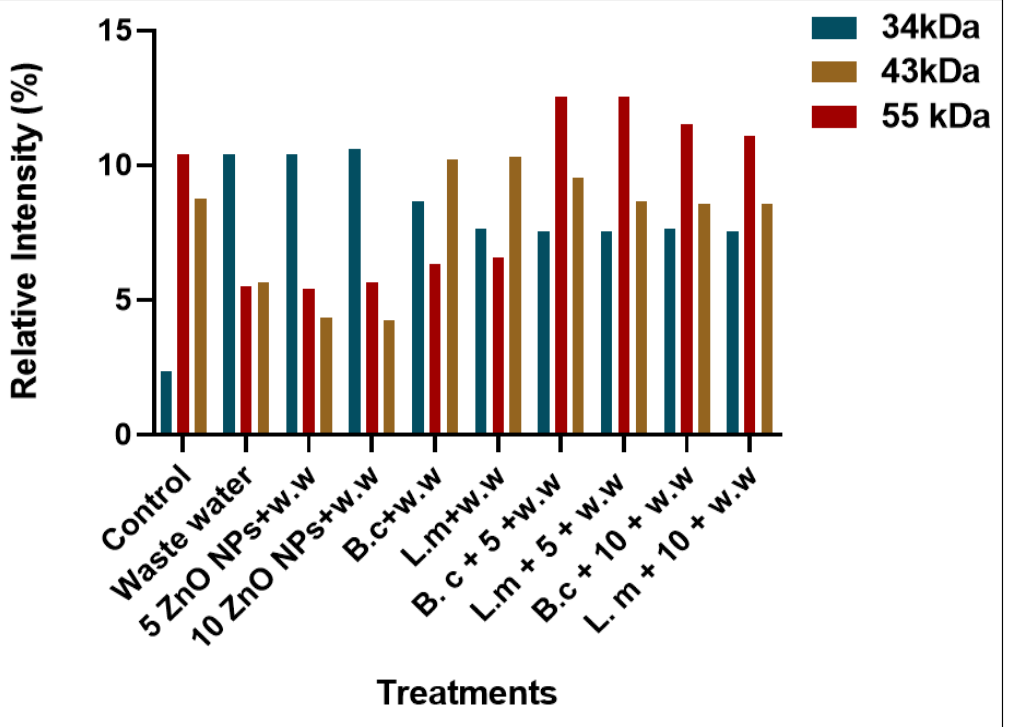
Figure 3. Protein banding profile that was detected on SDS-PAGE with CBB staining of rice plants that were grown by the synergistic treatment of seeds that were primed with bacteria and grown in ZnO NPs alone or in combination with HMs-contaminated water. (Lane 10: Wastewater (w.w), Lane 11: bio-priming with Bacillus cereus + w.w, Lane 12: bio-priming with Lysinibacillus macroides + w.w, Lane 13: 5 mg/L ZnO NPs + w.w treatment, Lane 14: 10 mg/L ZnO NPs + w.w treatment, Lane 15: Bacillus cereus + 5 mg/L ZnO NPs + w.w, Lane 16: Lysinibacillus macroides +5 mg/L ZnO NPs + w.w, Lane 17: Bacillus cereus + 10 mg/L ZnO NPs + w.w, Lane 18: Lysinibacillus macroides +10 mg/L ZnO NPs + w.w).